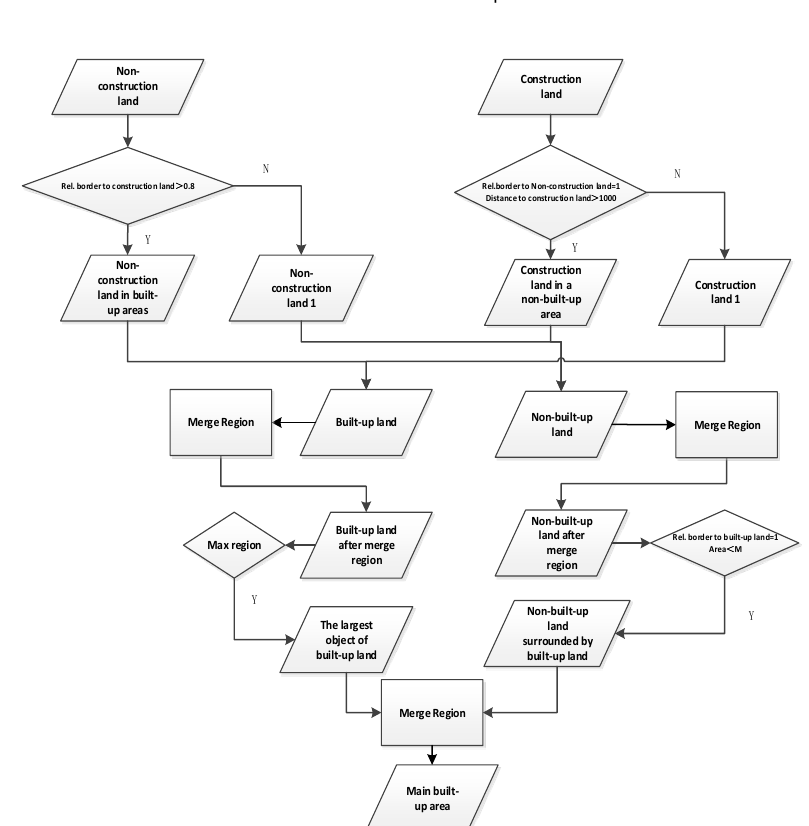
Figure 2. Automatic extraction process of urban main built-up